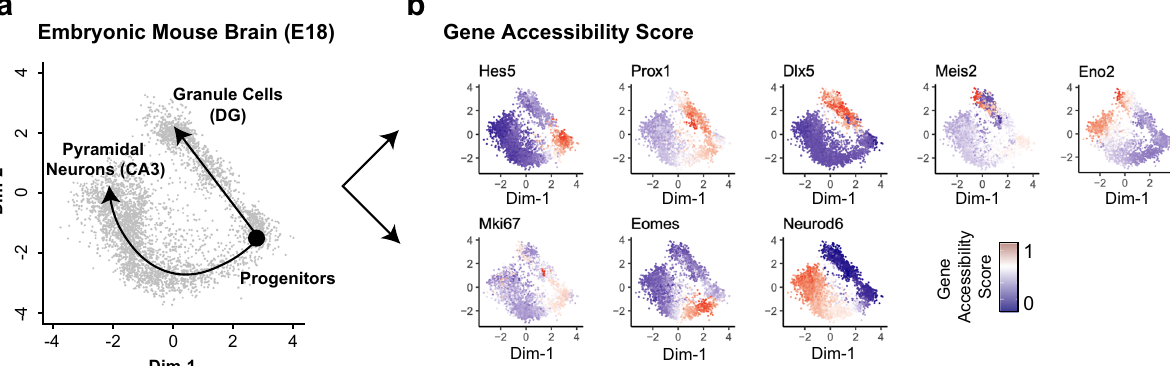
Fig. 3 SnapATAC constructs cellular trajectories for the developing mouse brain. a Two-dimensional visualization of a dataset that contains 4259 single- cell chromatin pro fi les from the hippocampus and ventricular zone in embryonic mouse brain (E18) reveals two-branch differentiation trajectories from progenitor cells to Granule Cells (DG) and Pyramidal Neurons (CA3) (left). Data source is listed in Supplementary Table 1. The cellular trajectory is determined using Slingshot. b Gene accessibility score (Methods section) of canonical marker genes is projected onto the 2D embedding.